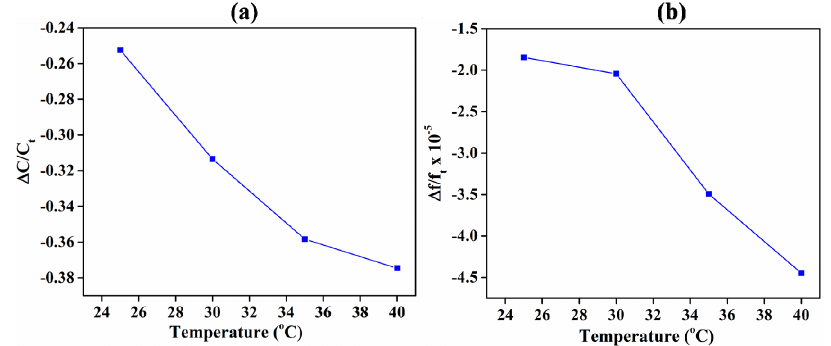
Figure 9. Sensitivity of the ZIF-8-coated sensors to changes in temperature. The acetone was fixed at 15.9 vol %. ( a ) Response of the capacitive sensor. ( b ) Response of the QCM sensor.